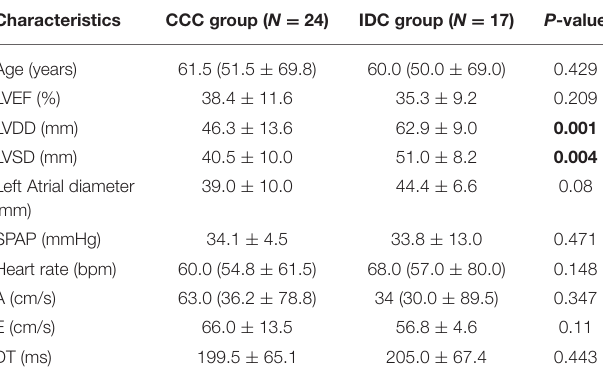
TABLE 1 | Demographic and clinical features of patients evaluated in the study for ex vivo T-cell analysis.